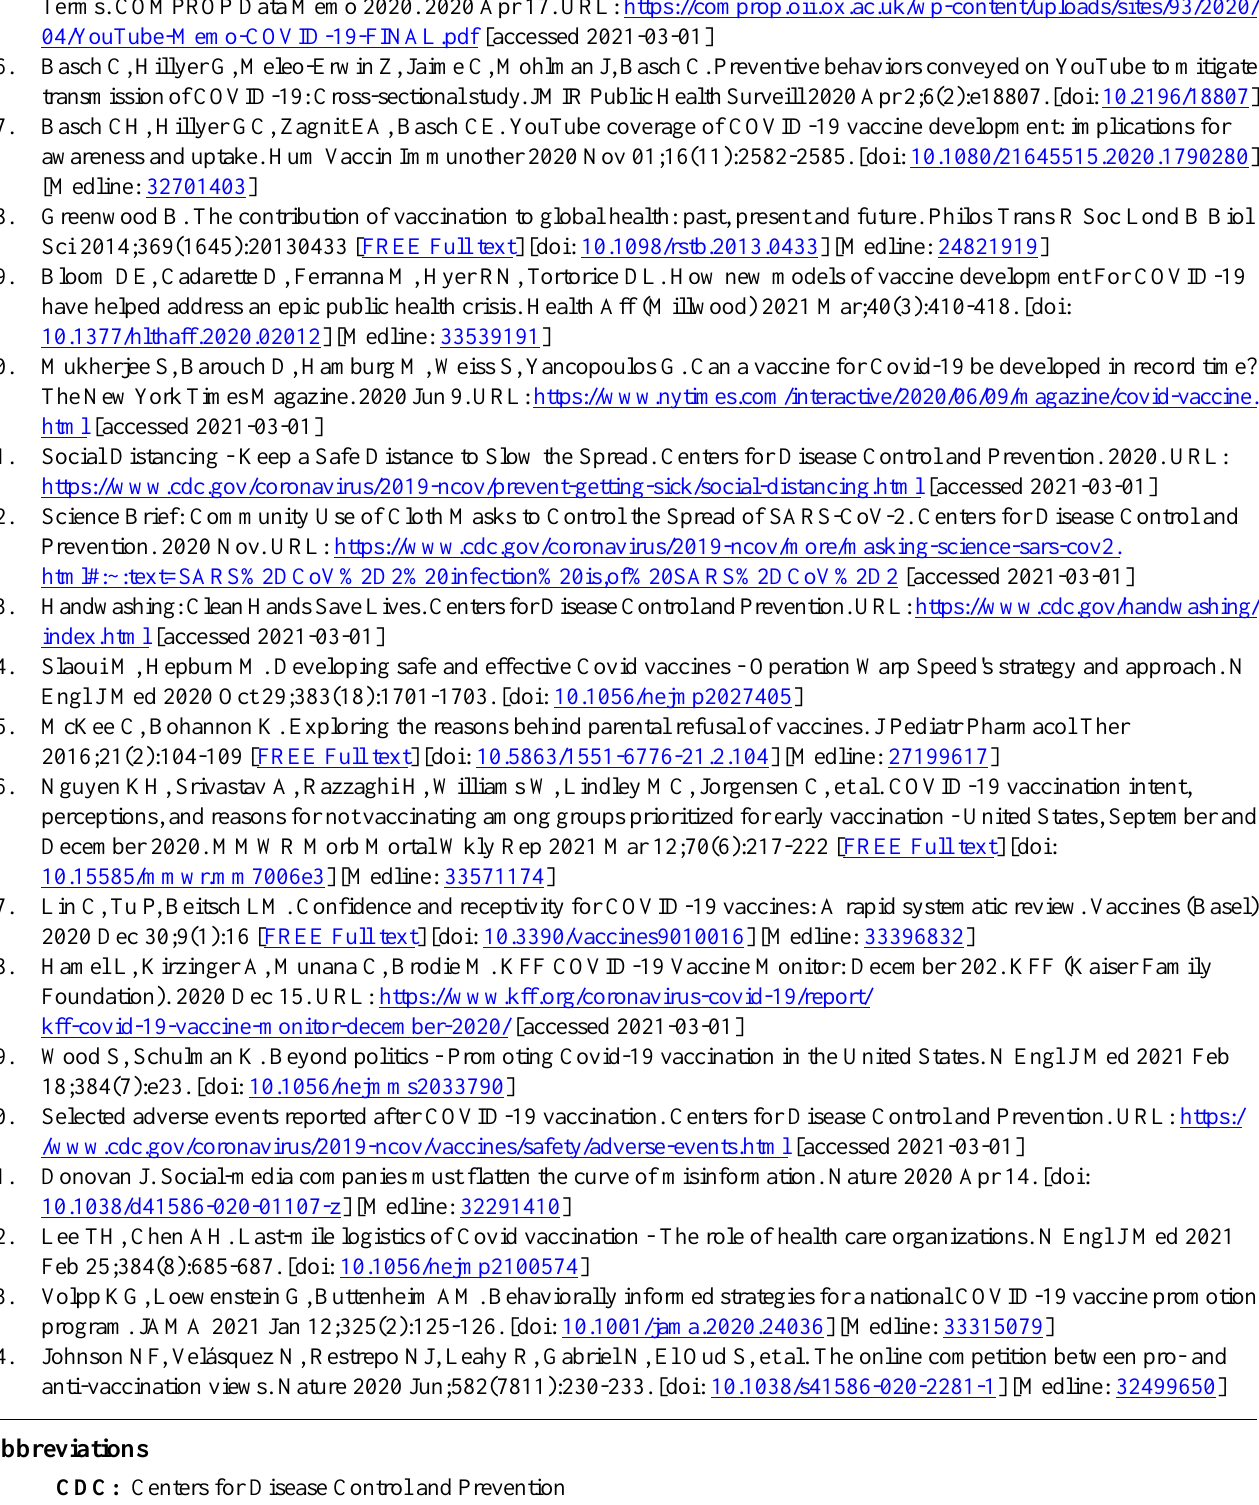
CDC: Centers for Disease Control and Prevention FDA: Food and Drug Administration mRNA: messenger RNA WHO: World Health